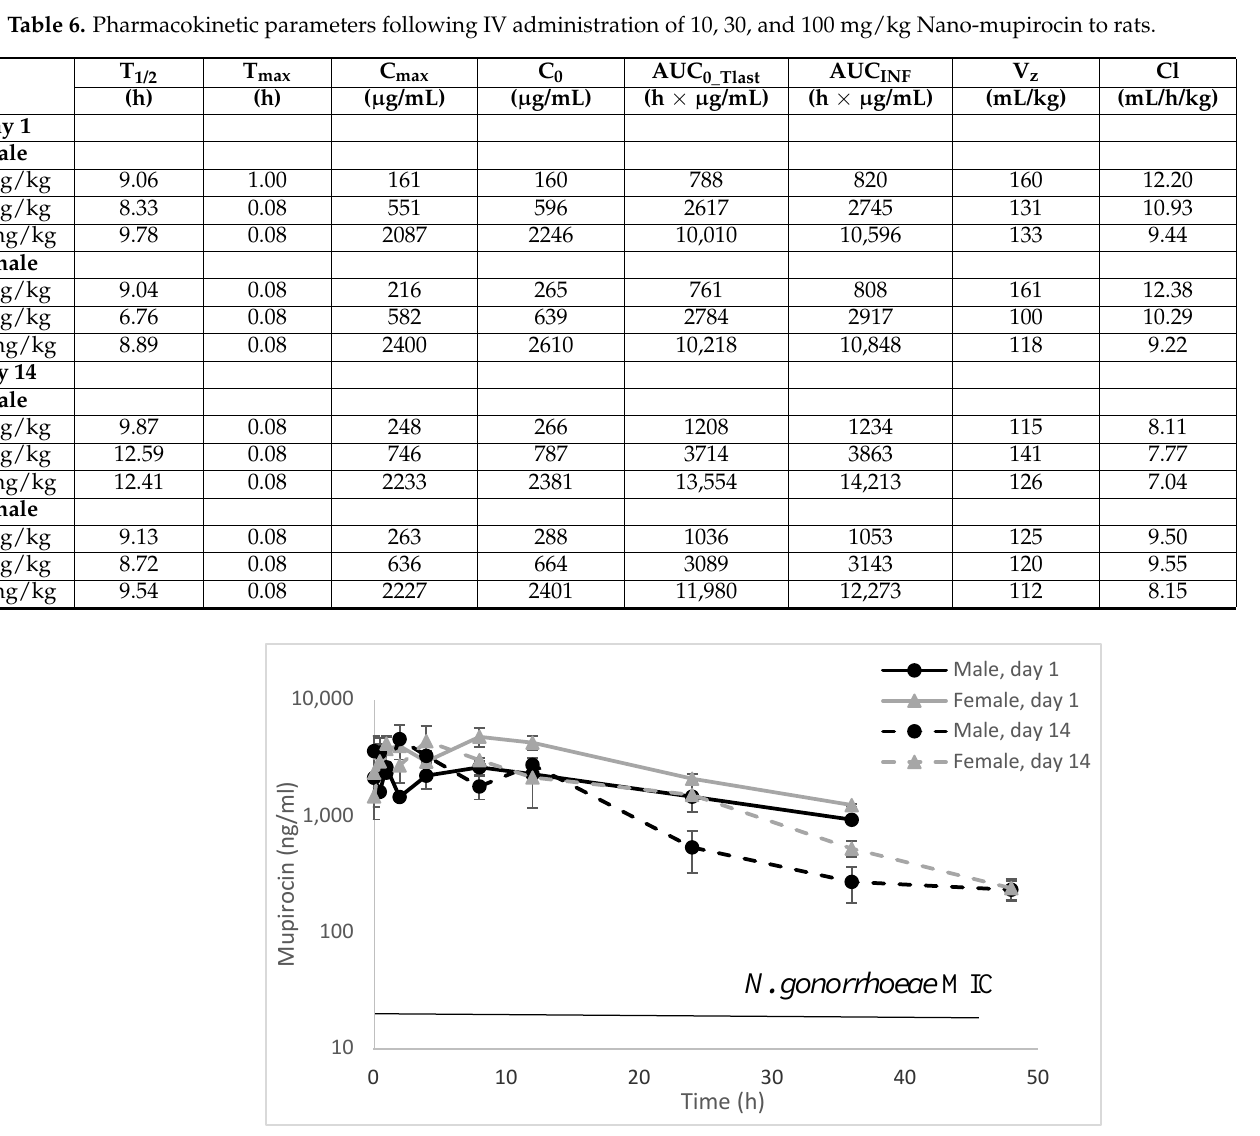
Figure 2. Mupirocin plasma concentrations (ng/ml) following IM administration of Figure 2. Total mupirocin (liposome-encapsulated plus non-liposomal drug plus plasma-protein- bound drug) concentration (ng/mL) following IM administration of 2.6 mg Nano-mupirocin to male 2.6 mg Nano-mupirocin to male and female rats on days 1 and 14. (n=3, mean ±SE). and female rats on days 1 and 14. ( n = 3, mean ± SE). Table 7. Pharmacokinetic parameters following IM administration of 2.6 mg Nano-mupirocin per